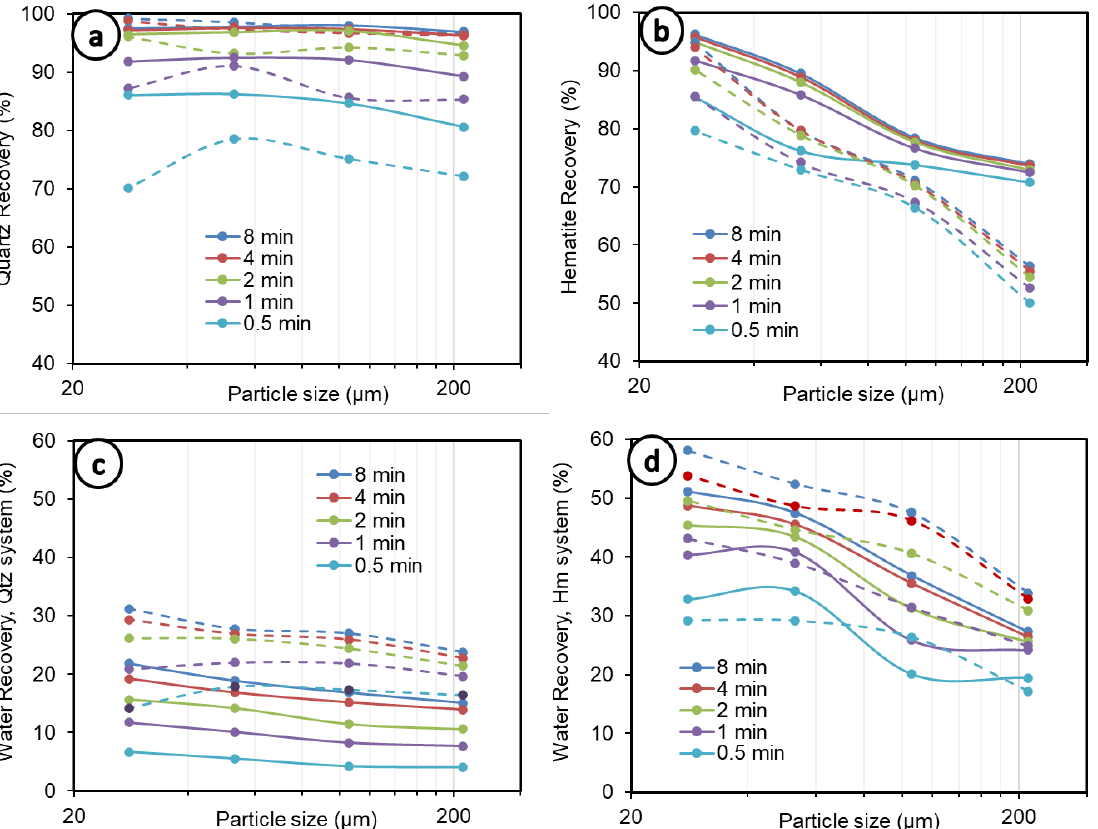
Figure 2. Recovery by size at different times. ( a ) Quartz recovery, ( b ) hematite recovery, ( c ) water recovery in quartz system, ( d ) water recovery in hematite system. Dashed lines represent 10 vol.% and 5 vol.% solid concentrations in the quartz and hematite systems, respectively, whereas solid lines depict 5 vol.% and 2.5 vol.% concentrations in both